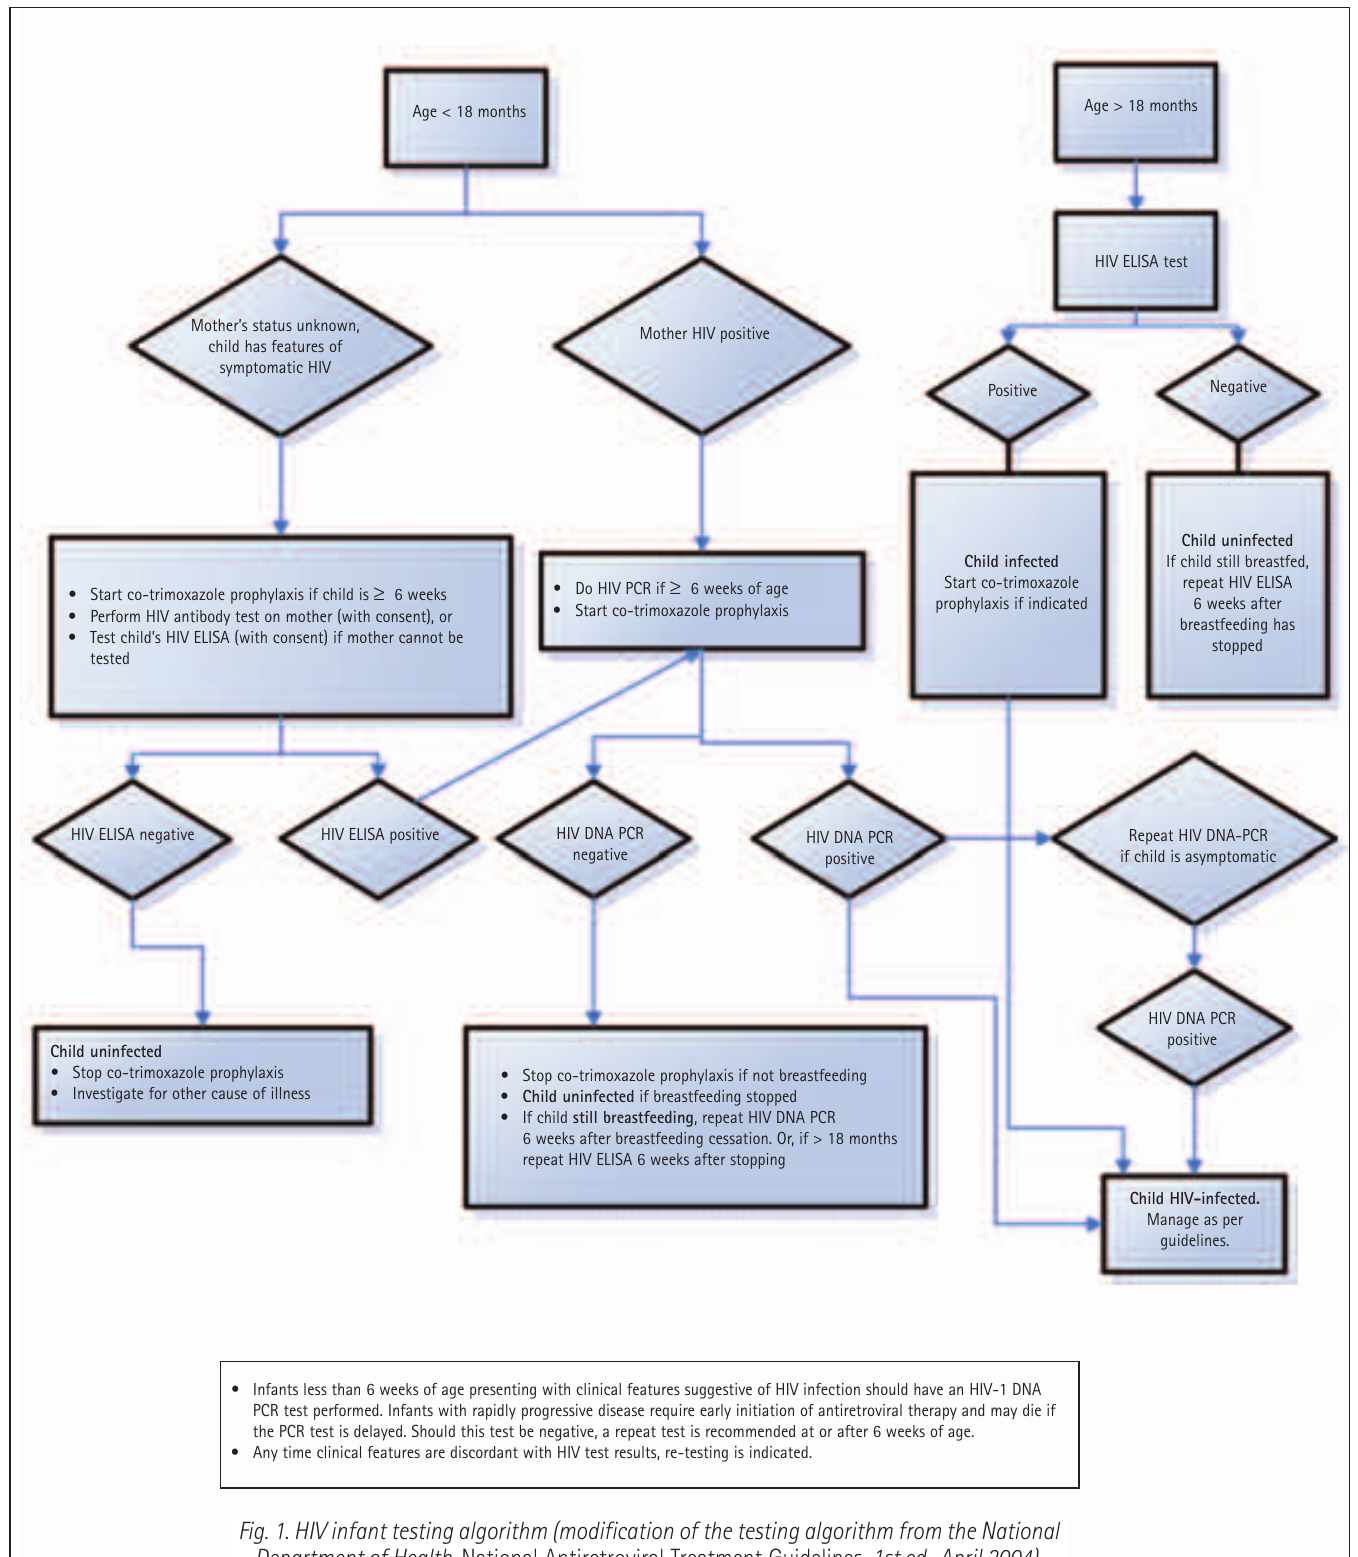
Fig. 1. HIV infant testing algorithm (modification of the testing algorithm from the National Department of Health, National Antiretroviral Treatment Guidelines , 1st ed., April